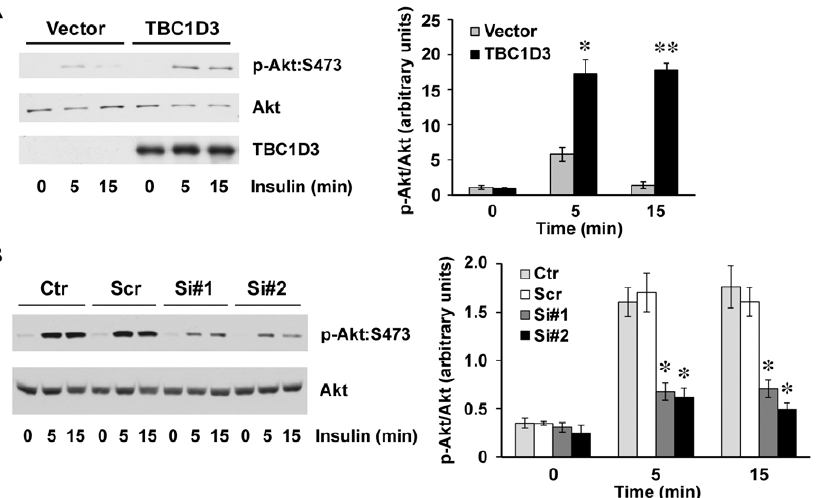
Figure 1. TBC1D3 increases signaling through the activation of insulin pathway. (A) HepG2 cells transfected with myc-TBC1D3 or empty vector were serum-starved, and stimulated with insulin (10 nM) for the indicated times. Phosphorylation and protein levels of Akt were analyzed by Western blotting. ( Right panel ) Quantification data of Akt:S473 phosphorylation normalized to Akt protein levels (* p , 0.05, ** p , 0.01). (B) HepG2 cells were transfected with two different TBC1D3 siRNA oligos (50 nM) (si # 1 and si # 2), scramble siRNA (scr) or untransfected (ctr). After 36 h, cells were serum-starved and stimulated with 10 nM insulin for the indicated times and analyzed by Western blotting with the listed antibodies. ( Right panel ) Quantification data of Akt:S473 phosphorylation normalized to Akt protein levels (* p , 0.05). The data are presented as means 6 SD of three independent experiments.